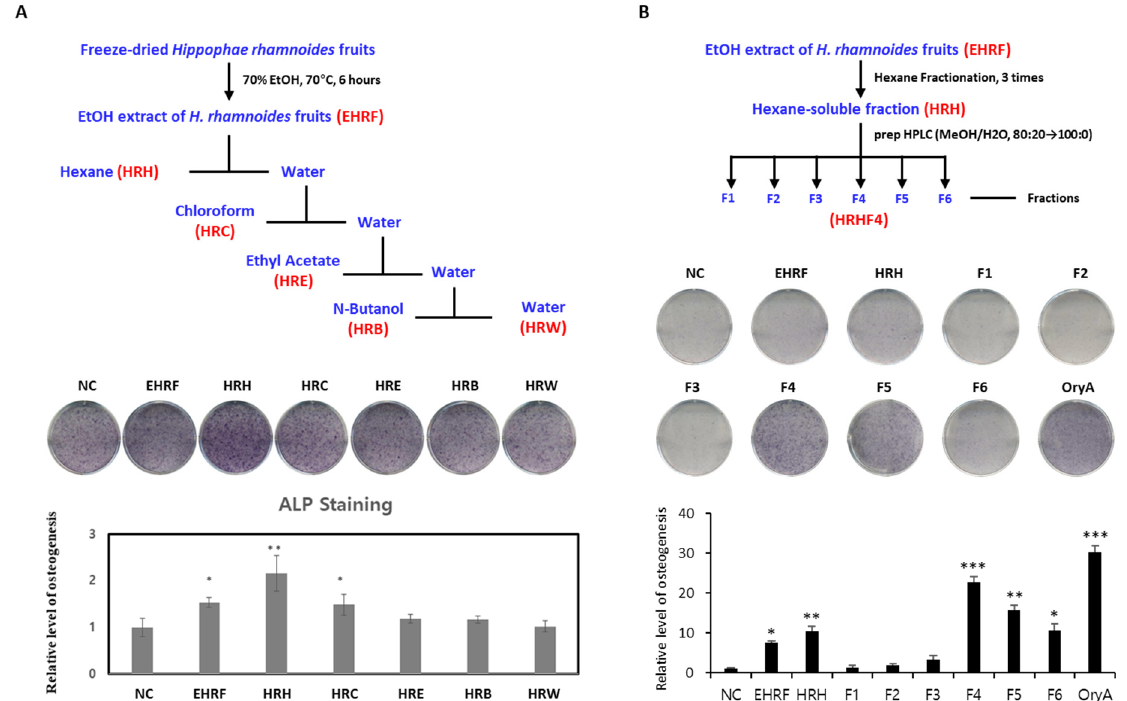
Figure 1. Evaluation of the effects of each fraction from the EtOH extract of H. rhamnoides fruits on osteogenesis. ( A ) Stimulatory effect of each solvent soluble fractions, derived from the process above, on the osteogenic differentiation of mesenchymal stem cells (MSCs) into osteoblasts. Fully differentiated C3H10T1/2 cells were stained with alkaline phosphatase (ALP) after 9 days of osteogenic differentiation with 50 µ g/mL of each isolated extract. The relative levels were calculated by setting the negative control (NC) to 1. ( B ) Stimulatory effects of each extract, derived from the process above, on osteogenic differentiation of MSCs toward osteoblasts. Fully differentiated C3H10T1/2 cells were stained with ALP after 9 days of osteogenic differentiation with 50 µ g/mL of each isolated extract. The relative levels were calculated by setting the negative control (NC) to 1. Oryzativol A (5 µ M, 3.64 µ g/mL), which has been proven to be effective in osteogenesis, was used as a positive control and marked as OryA. *, **, and *** indicate difference from nontreated control. * denotes 0.01 ≤ p ≤ 0.05; ** denotes 0.001 ≤ p < 0.01; and *** denotes p <